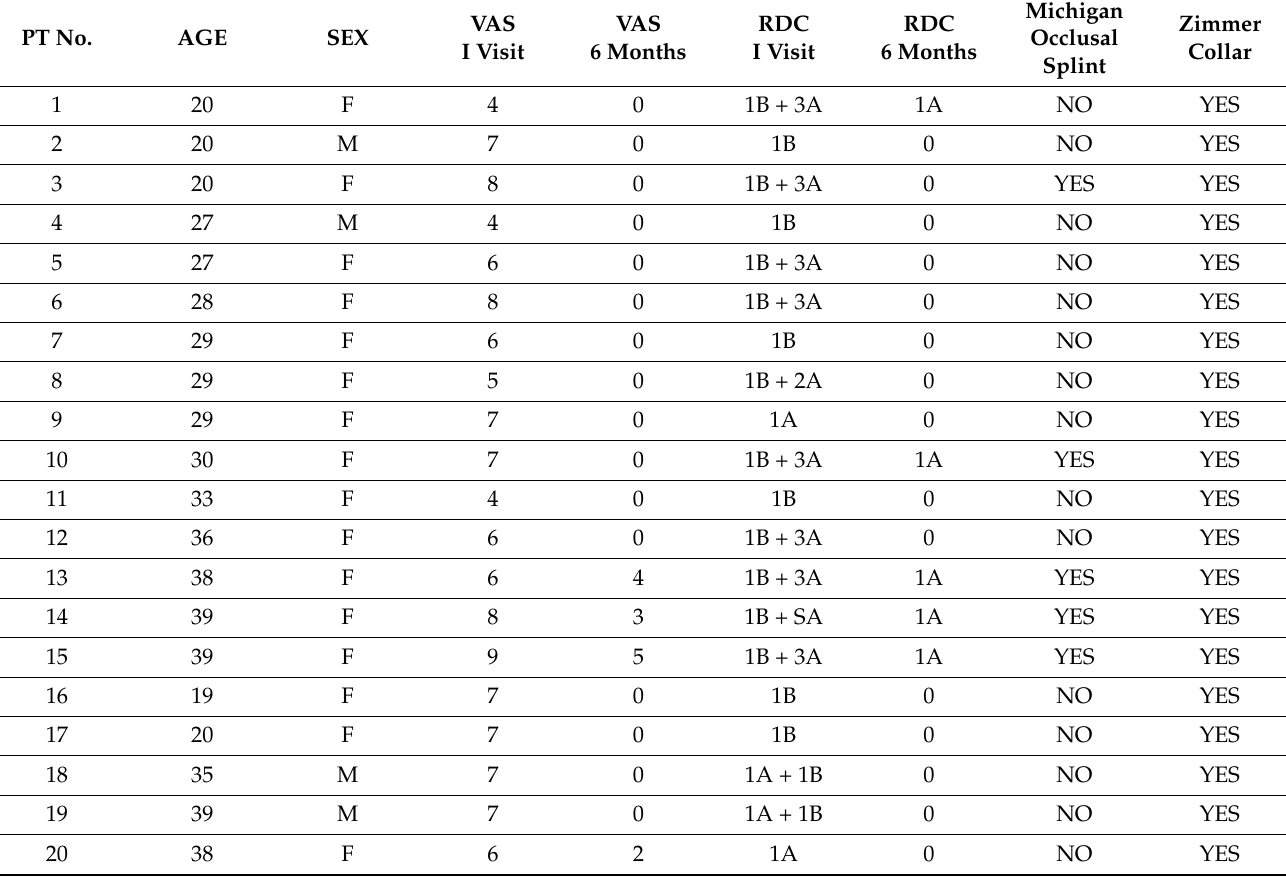
Table 2. Study group results (Zimmer collar users).